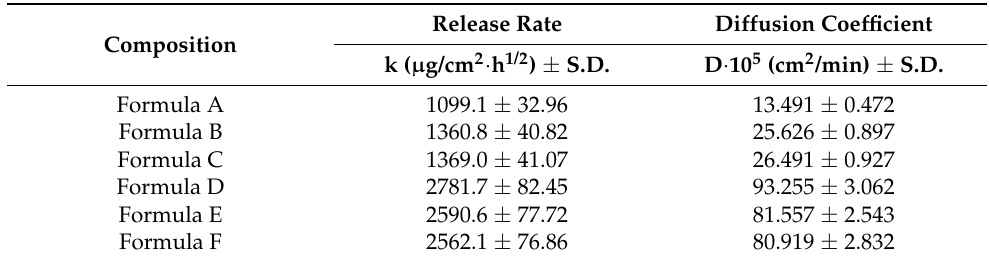
Table 5. Methyl salicylate release rate and the diffusion coefficient values related to the formulations. Each data point represents the mean ± S.D., n = 6.